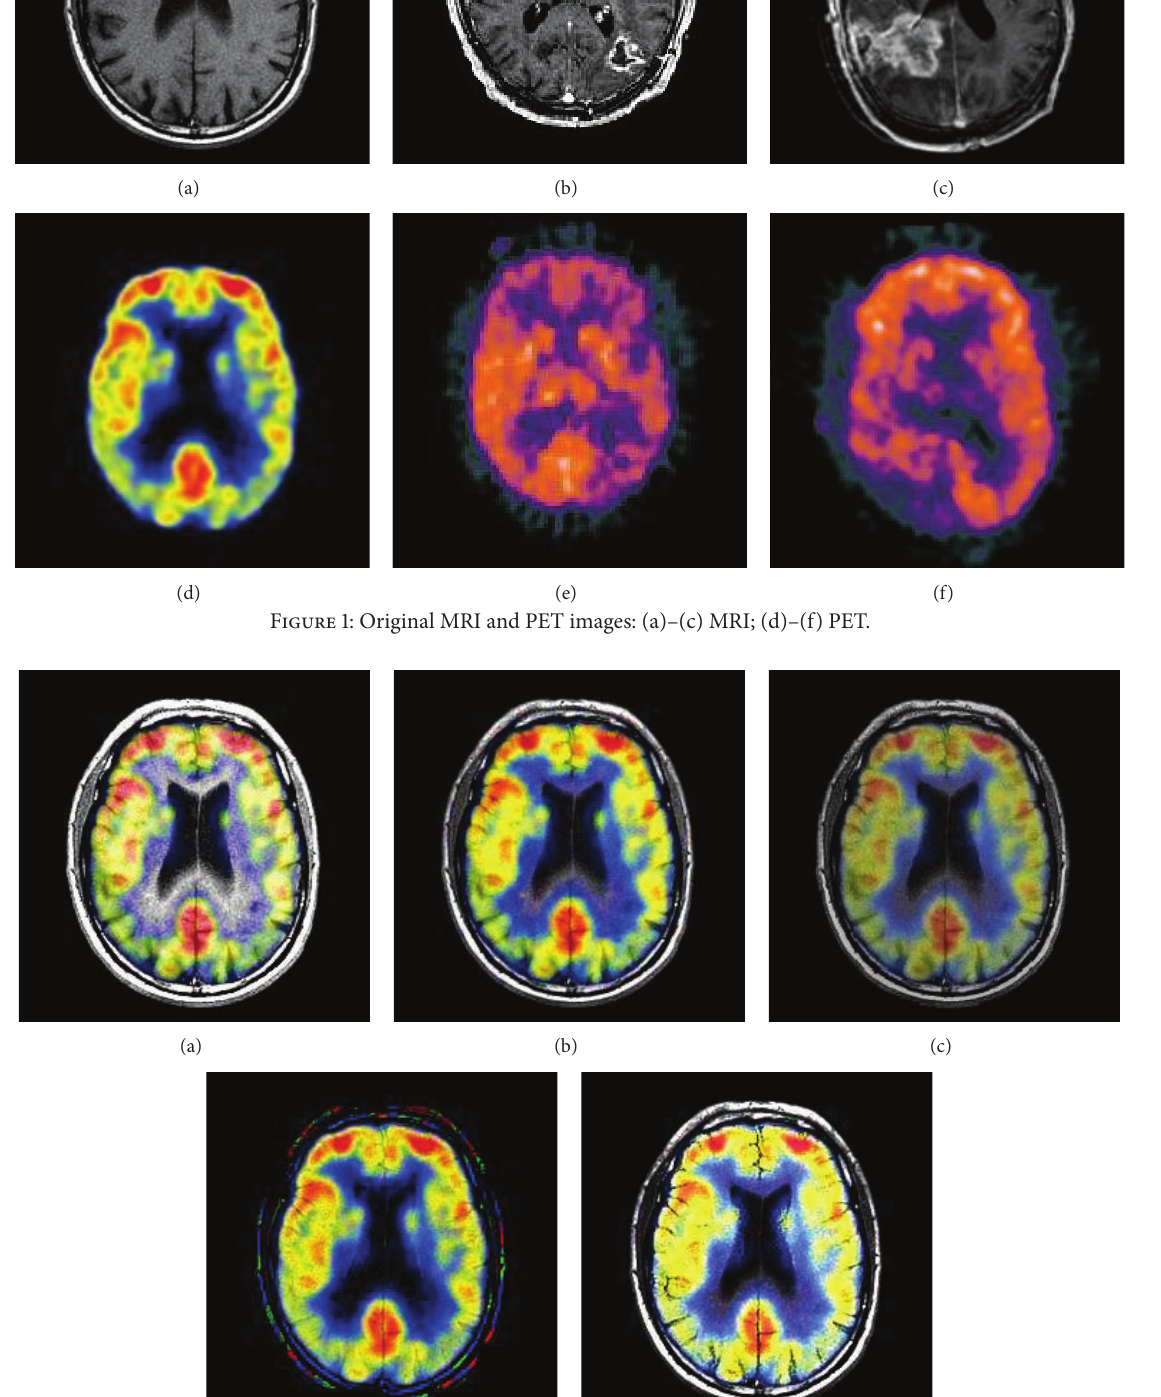
Figure 2: Image fusion results for normal images: (a) DWT [12]; (b) GIHS [6]; (c) GFF [33]; (d) IAWP [23]; (e) proposed